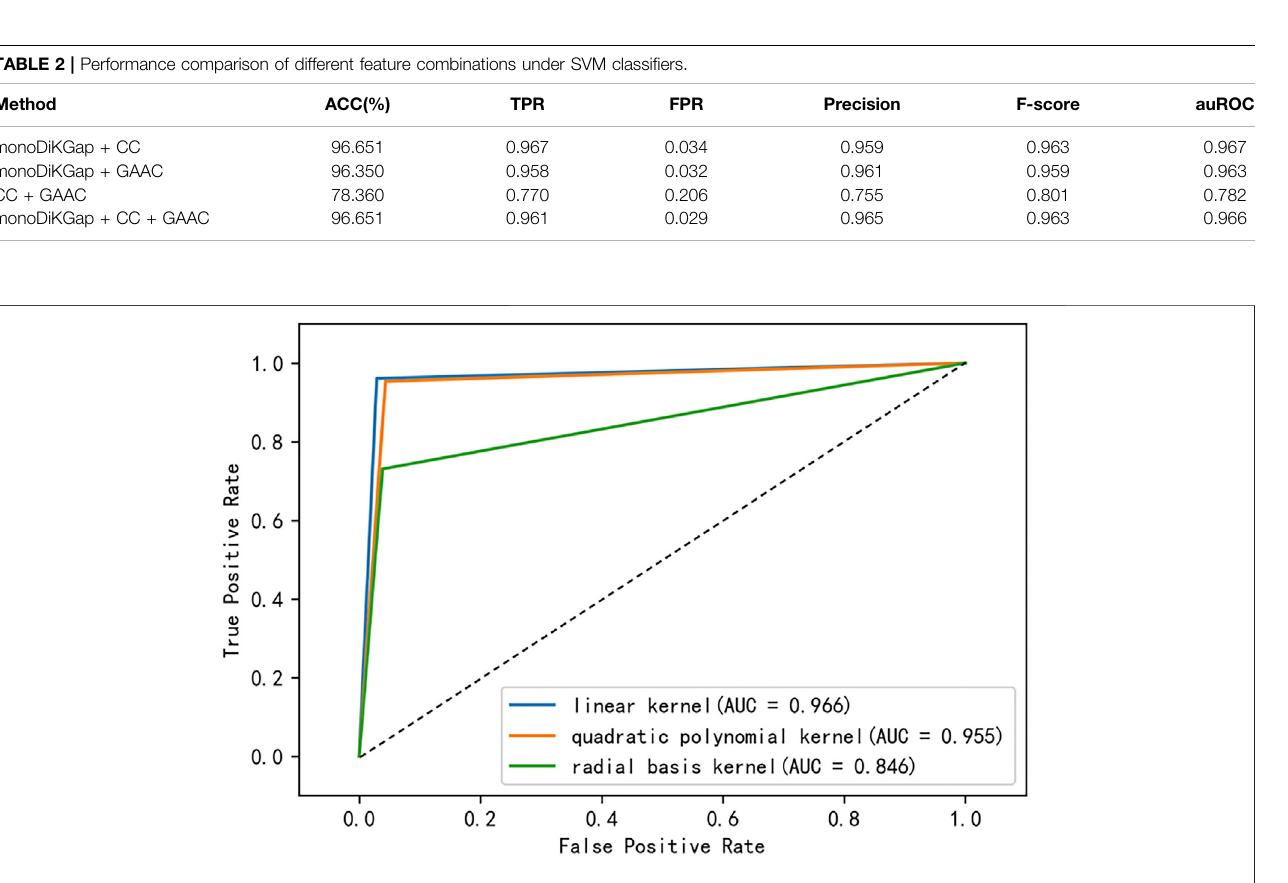
FIGURE 4 | ROC curves of support vector machines in different kernel functions.